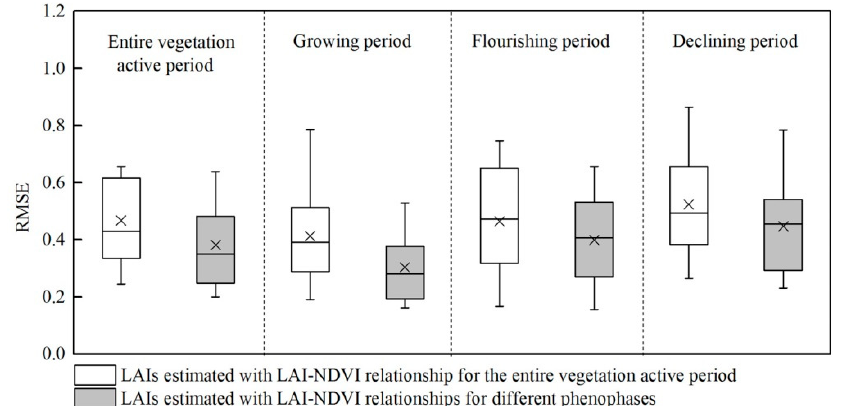
Figure 4. The root-mean-square errors (RMSEs) for the LAIs estimated based on a single LAI-NDVI relationship for the entire vegetation active period and those based on the piecewise LAI-NDVI relationships for different phenophases. See Figure 2 for descriptions of the boxplot.